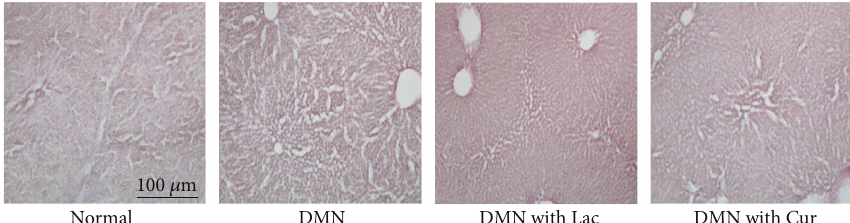
Lac100 𝜇 m Normal DMN DMN with CurDMN with Figure 4: Histological observation of fi brotic liver tissues after curcumin and lactulose treatment. Sections obtained by frozen section were subjected to H&E staining. DMN (10 mg/kg) or sterile saline was injected into the rat peritoneum three times per week for 4 weeks. A solution of curcumin, lactulose, or normal saline was given daily through oral administration for 28